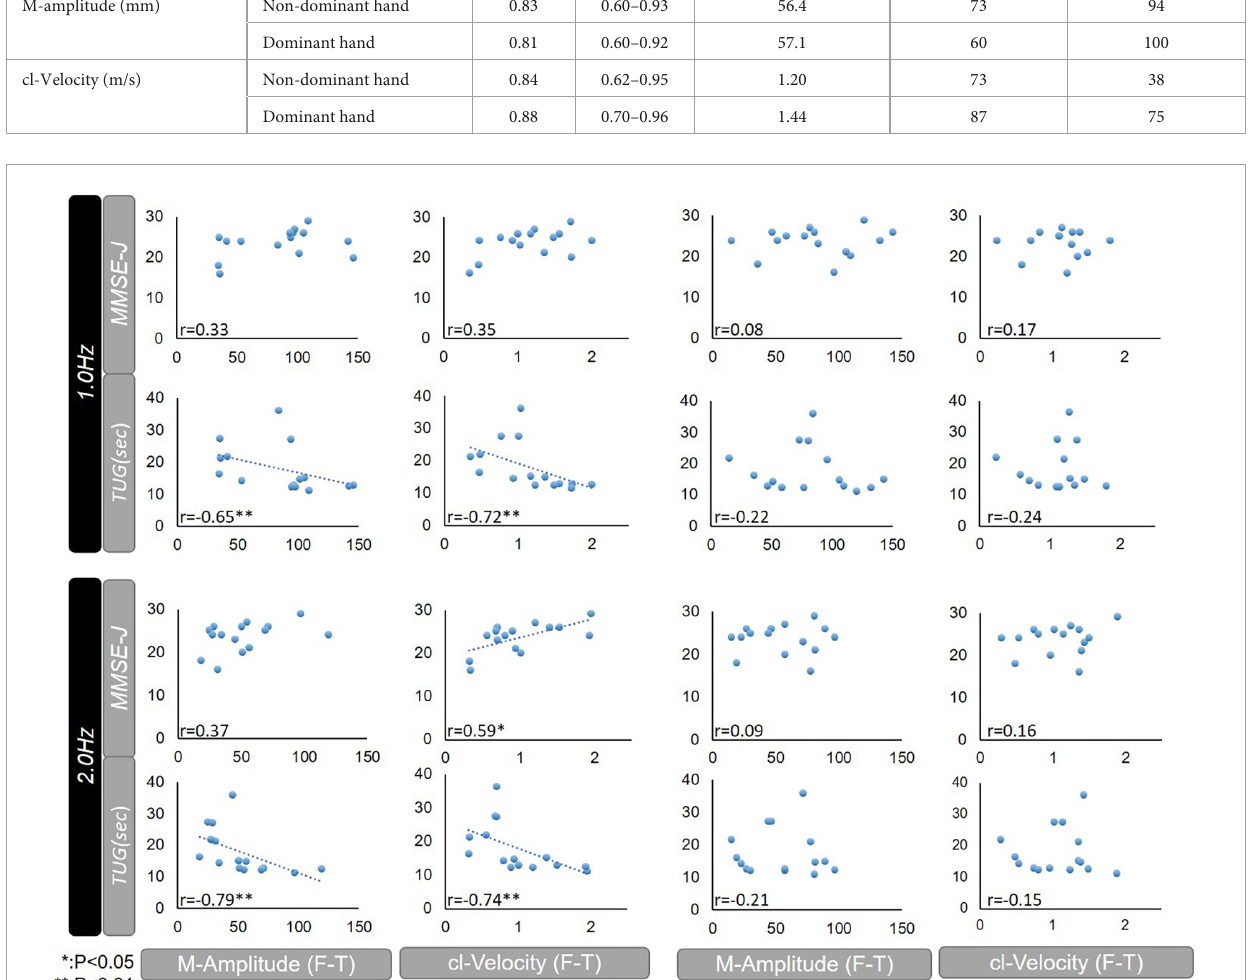
FIGURE3 Correlations between MMSE-J or TUG, and F-T parameters (M-Amplitude or cl-Velocity) among patients with iNPH. MMSE-J, Mini Mental State Examination-Japanese; TUG, Timed up and go test; F-T, finger tapping; M-Amplitude, the mean of maximum amplitude; cl-Velocity, the maximum of closing movement velocity; iNPH, idiopathic normal pressure hydrocephalus; CV, coefficient of variation; NS, not significant; ∗ p < 0.05, ∗∗ p <